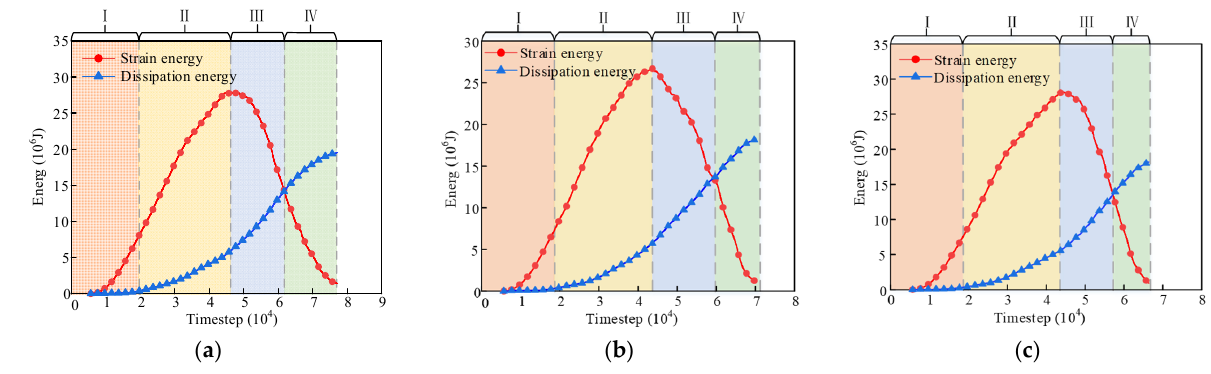
Figure 10. Energy evolution law of roadway surrounding rock. ( a ) RSR-1; ( b ) RSR-2; ( c ) RSR-3.